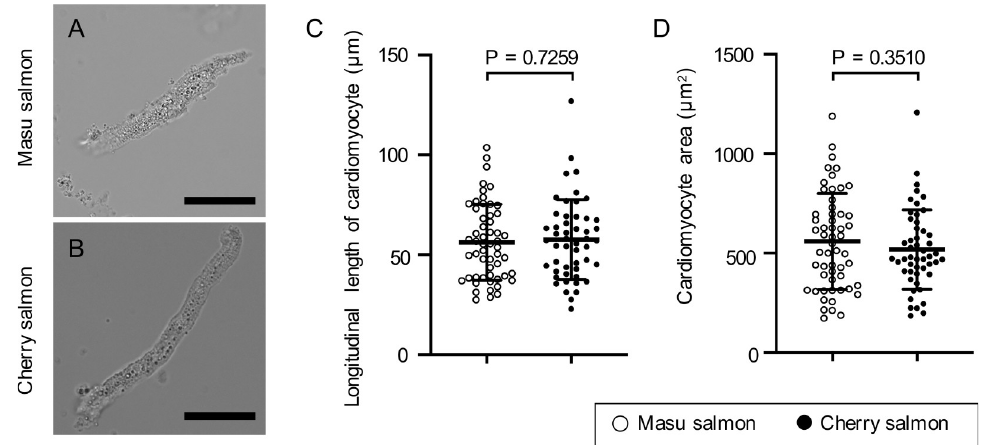
Fig 4. Morphology and sizes of the isolated cardiomyocytes. (A, B) Representative bright-field images of the primary cultured cardiomyocytes of masu and cherry salmon 29 mpf. Scale bars = 20 μ m. (C) Length of the long axis of the isolated cardiomyocytes; masu salmon (56 ± 19 μ m, N = 55), cherry salmon (58 ± 20 μ m, N = 50). (D) Area of the isolated cardiomyocytes; masu salmon (559 ± 239 μ m 2 , N = 55), cherry salmon (518 ± 197 μ m 2 , N = 50). Lines and error bars indicate the mean ± standard deviation. � : masu salmon, ● : cherry salmon. Actual measurements of cardiomyocyte morphology are shown in the S4 File.